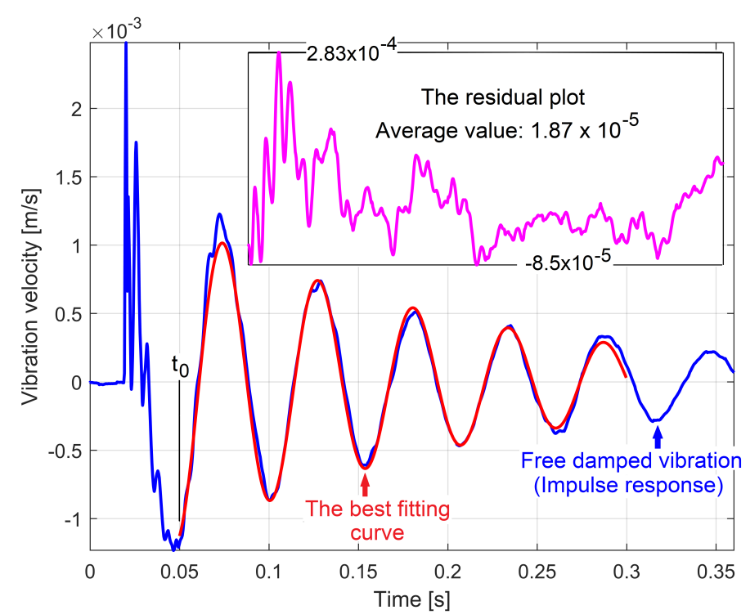
Figure 17. Some experimental results on signal processing related to free damped vibration of headstock after an impulse excitation (with a rubber mallet).